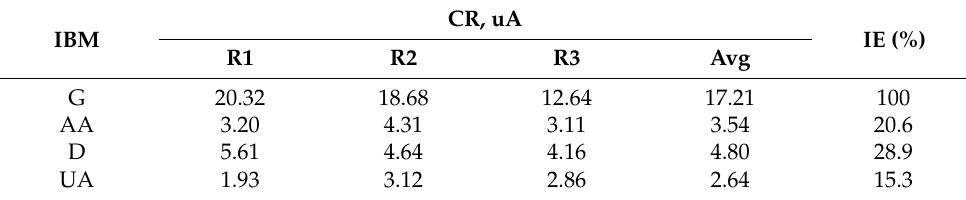
Table 2. Interference effect of similar biomolecules towards ZnO/V 2 O 5 sensing